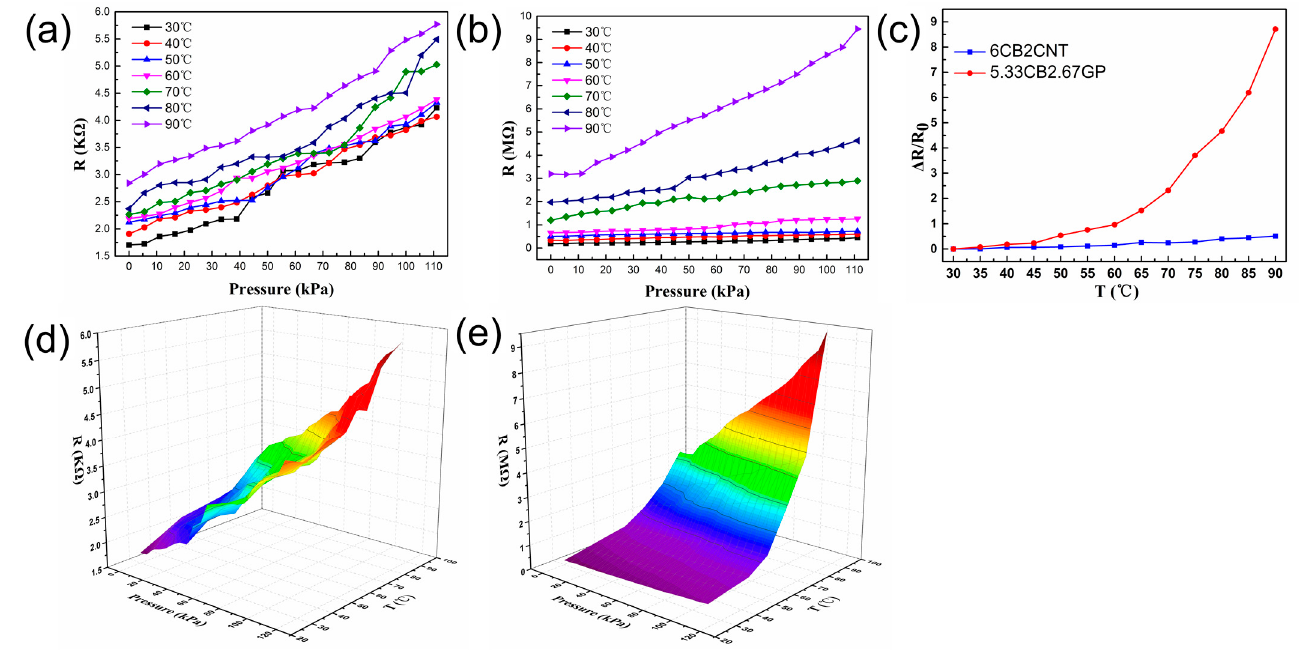
Figure 6. Changes in resistance of the 5.33CB2.67GP-RTV ( a ) and 6CB2CNT-RTV ( b ) sensor units as a function of pressure under different temperature gradients, ( c ) relative changes in resistance of the stretchable multimodal tactile sensor based on 5.33CB2.67GP-RTV and 6CB2CNT-RTV as a function of temperature, where the 3D surfaces were used to comprehensively illustrate the changes in resistance of the sensor units based on 5.33CB2.67GP-RTV ( d ) and 6CB2CNT-RTV ( e ).